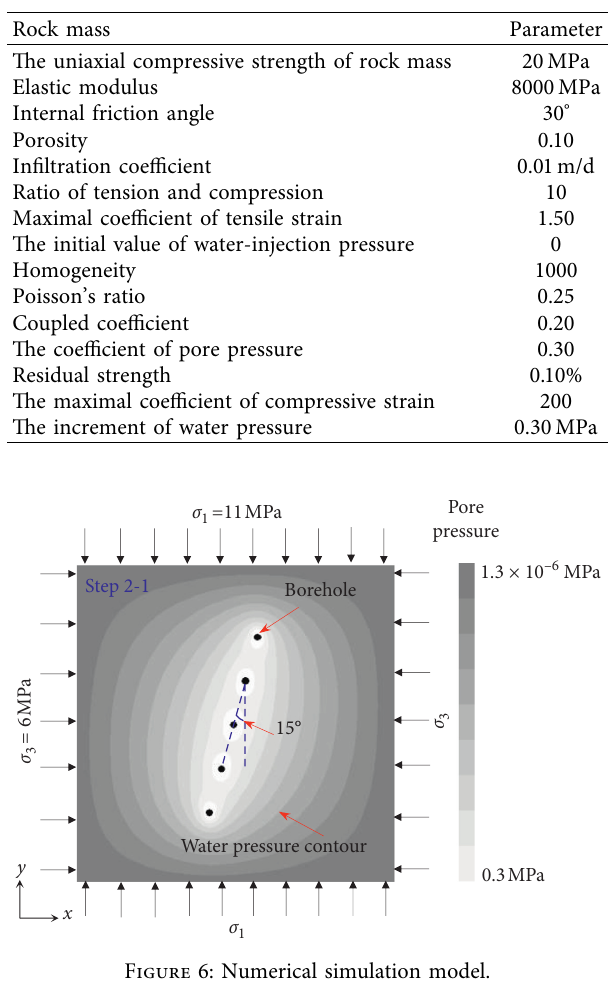
Table 2: Numerical simulation parameters.